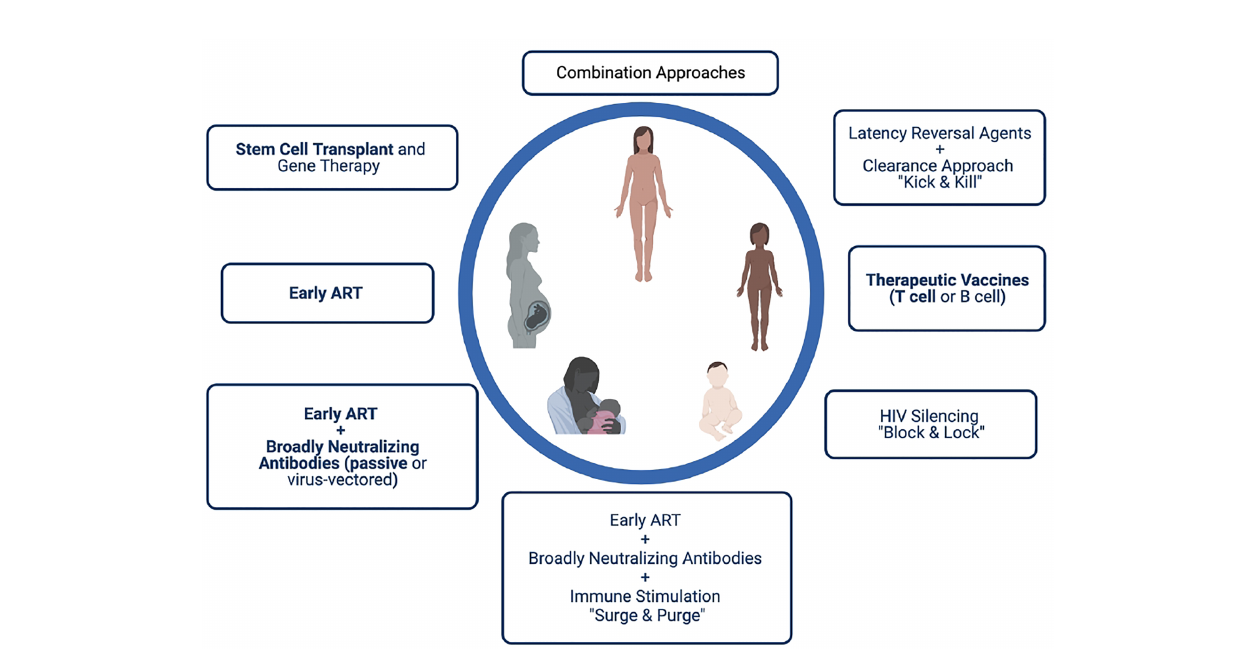
FIGURE 2 | Possible HIV cure approaches for perinatally infected infants, children and adolescents. Strategies in bold have been or are being studied in pediatric clinical